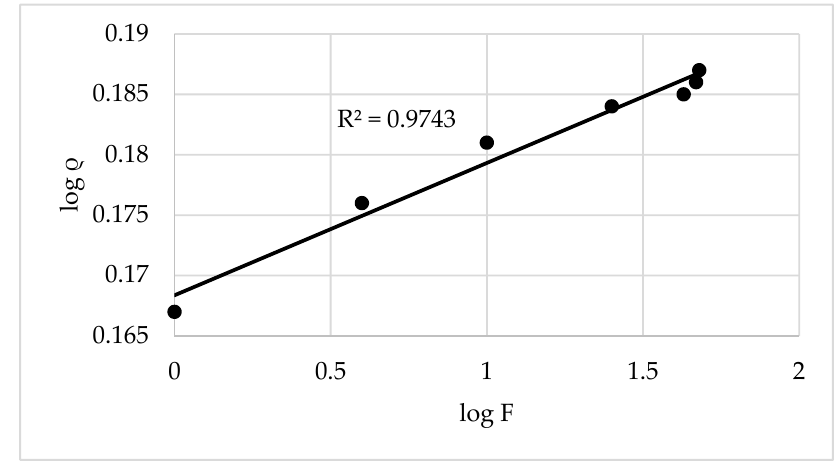
(cid:37) on F in double logarithmic Figure 3. Linearized dependence of ρ on F in double logarithmic coordinates. Figure 3. Linearized dependence of